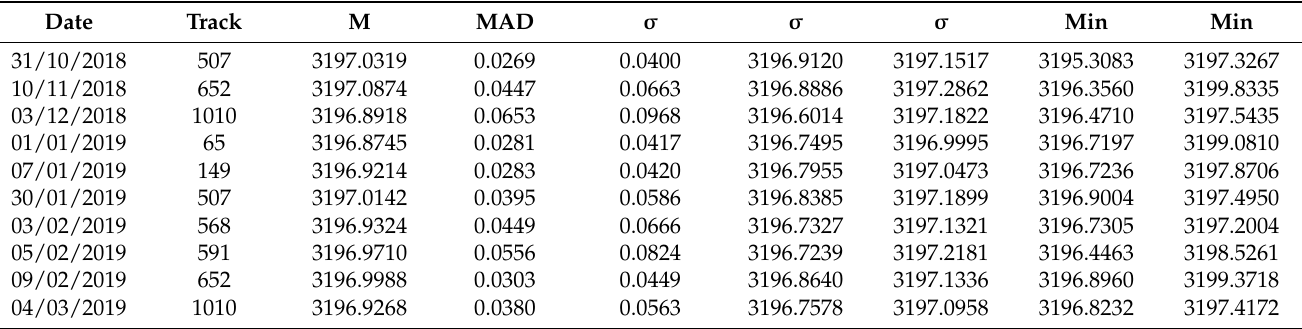
Table A3. The parameters of the MAD outlier method for the corresponding dates of